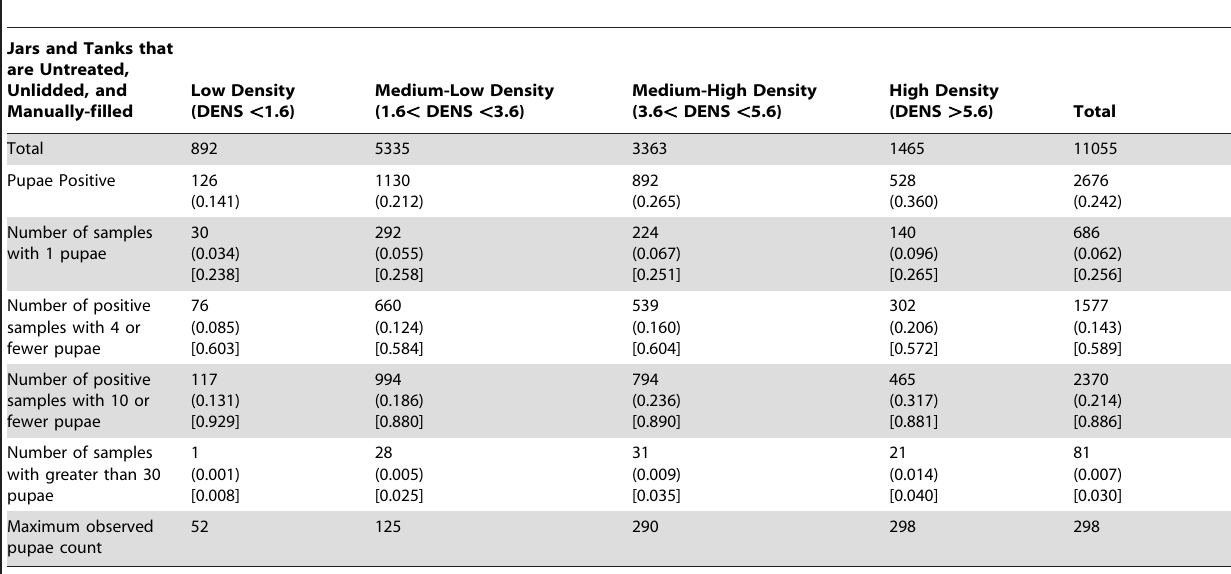
Table 4. The relationship between Ae. aegypti productivity and development site density for unprotected water storage jars and